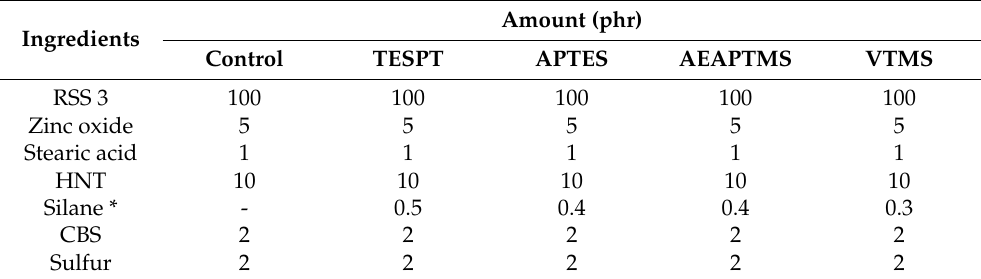
Table 1. The formulation used for compounding NR/HNT composites filled with and without silane coupling agents.